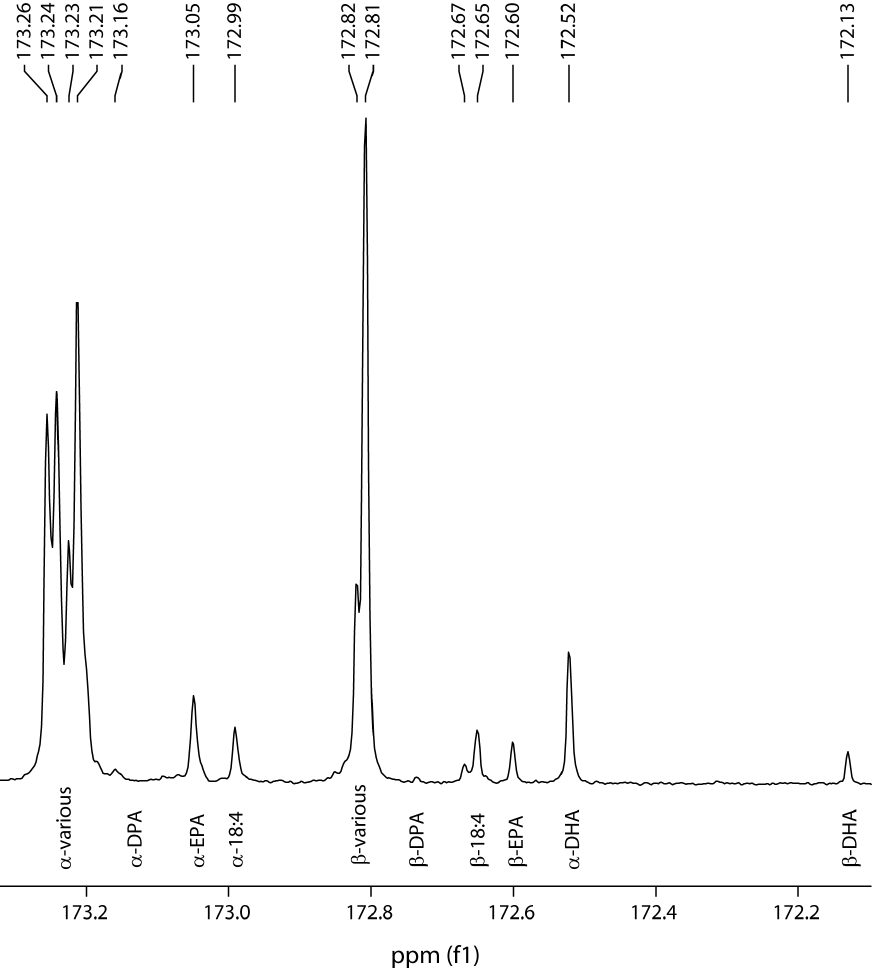
Figure 8. Trace of a 13 C-NMR spectrum of the carbonyl (C1) region showing the positional distribution of EPA and DHA in transgenic Camelinasativa TAG with the sn -1,3 positions indicated by a and sn -2 by b . Both EPA and DHA are preferentially located at sn - 1,3, although the effect is weaker for EPA.